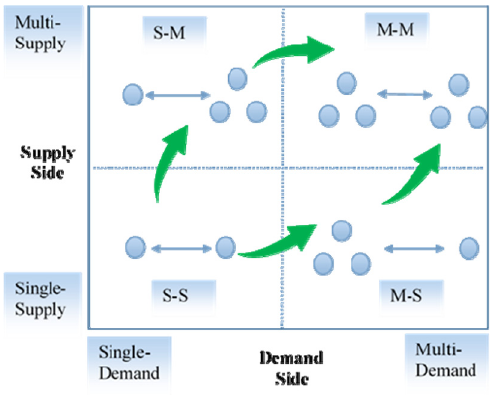
Figure 4. Division